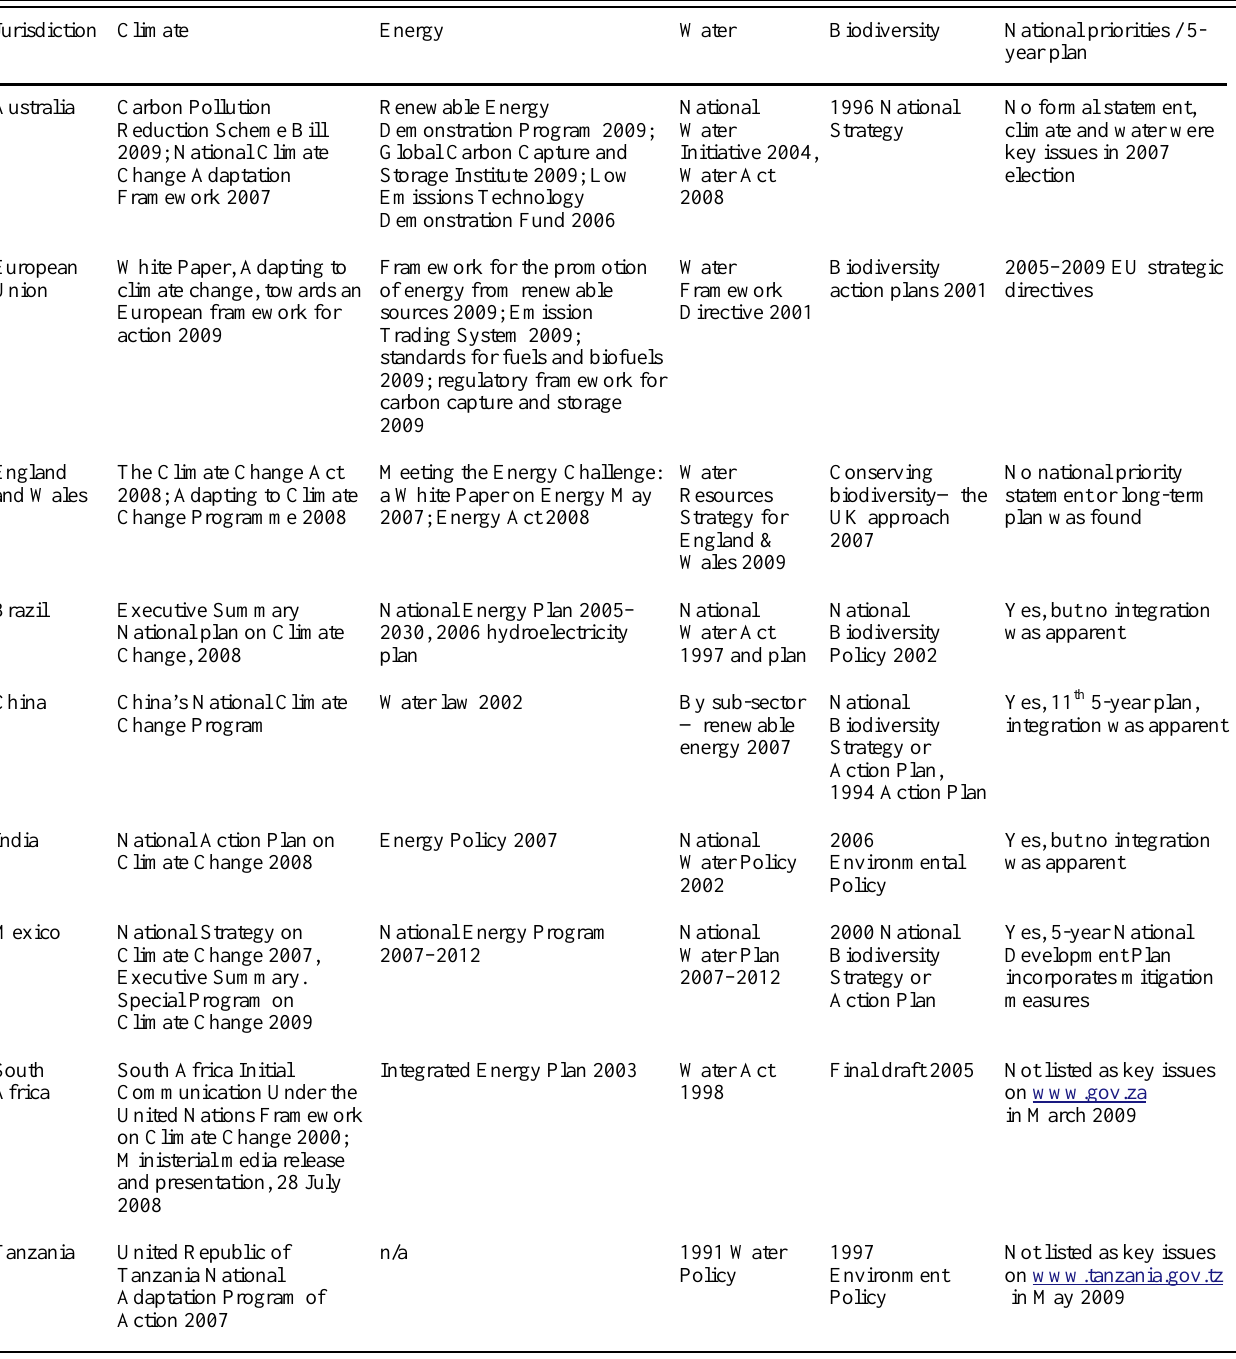
Table 1. Policy data sources by